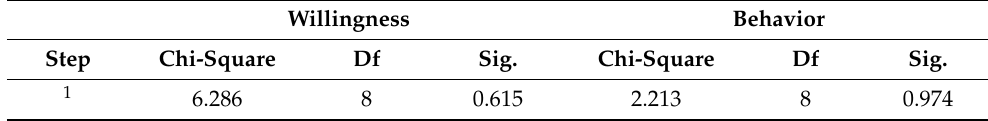
Table 4. Goodness-of-fit using the Hosmer and Lemeshow test for regression models.